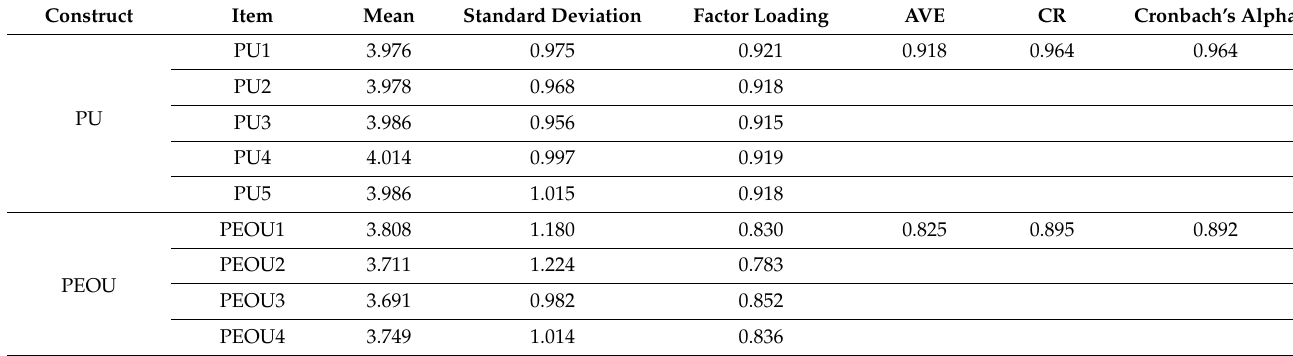
Table 4. Results for convergent validity and reliability assessment of the